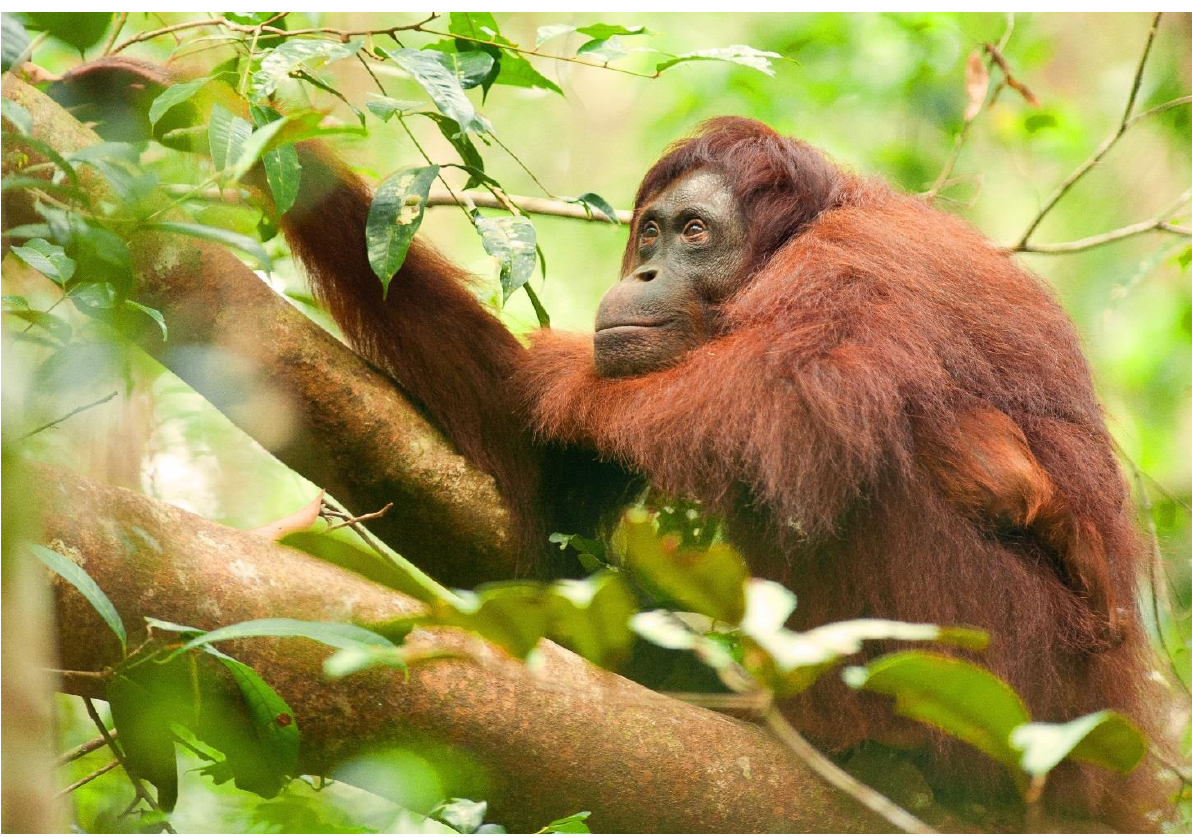
Figure 1. Bornean orangutan ( Pongo pygmaeus wurmbii ). Photo: Andrew Walmsley /